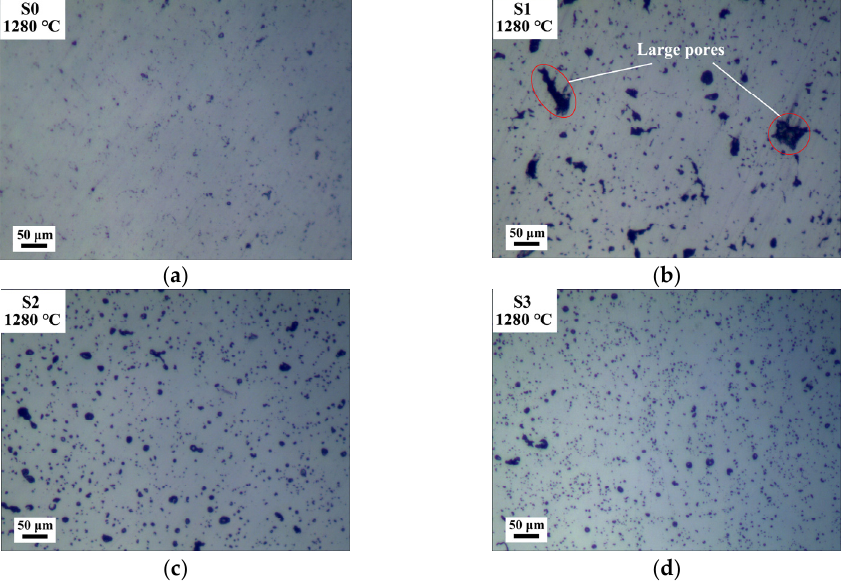
Figure 4. Microstructures of ( a ) 1280-S0, ( b ) 1280-S1, ( c ) 1280-S2 and ( d ) 1280-S3 ODS steels obtained by metallographic microscope.